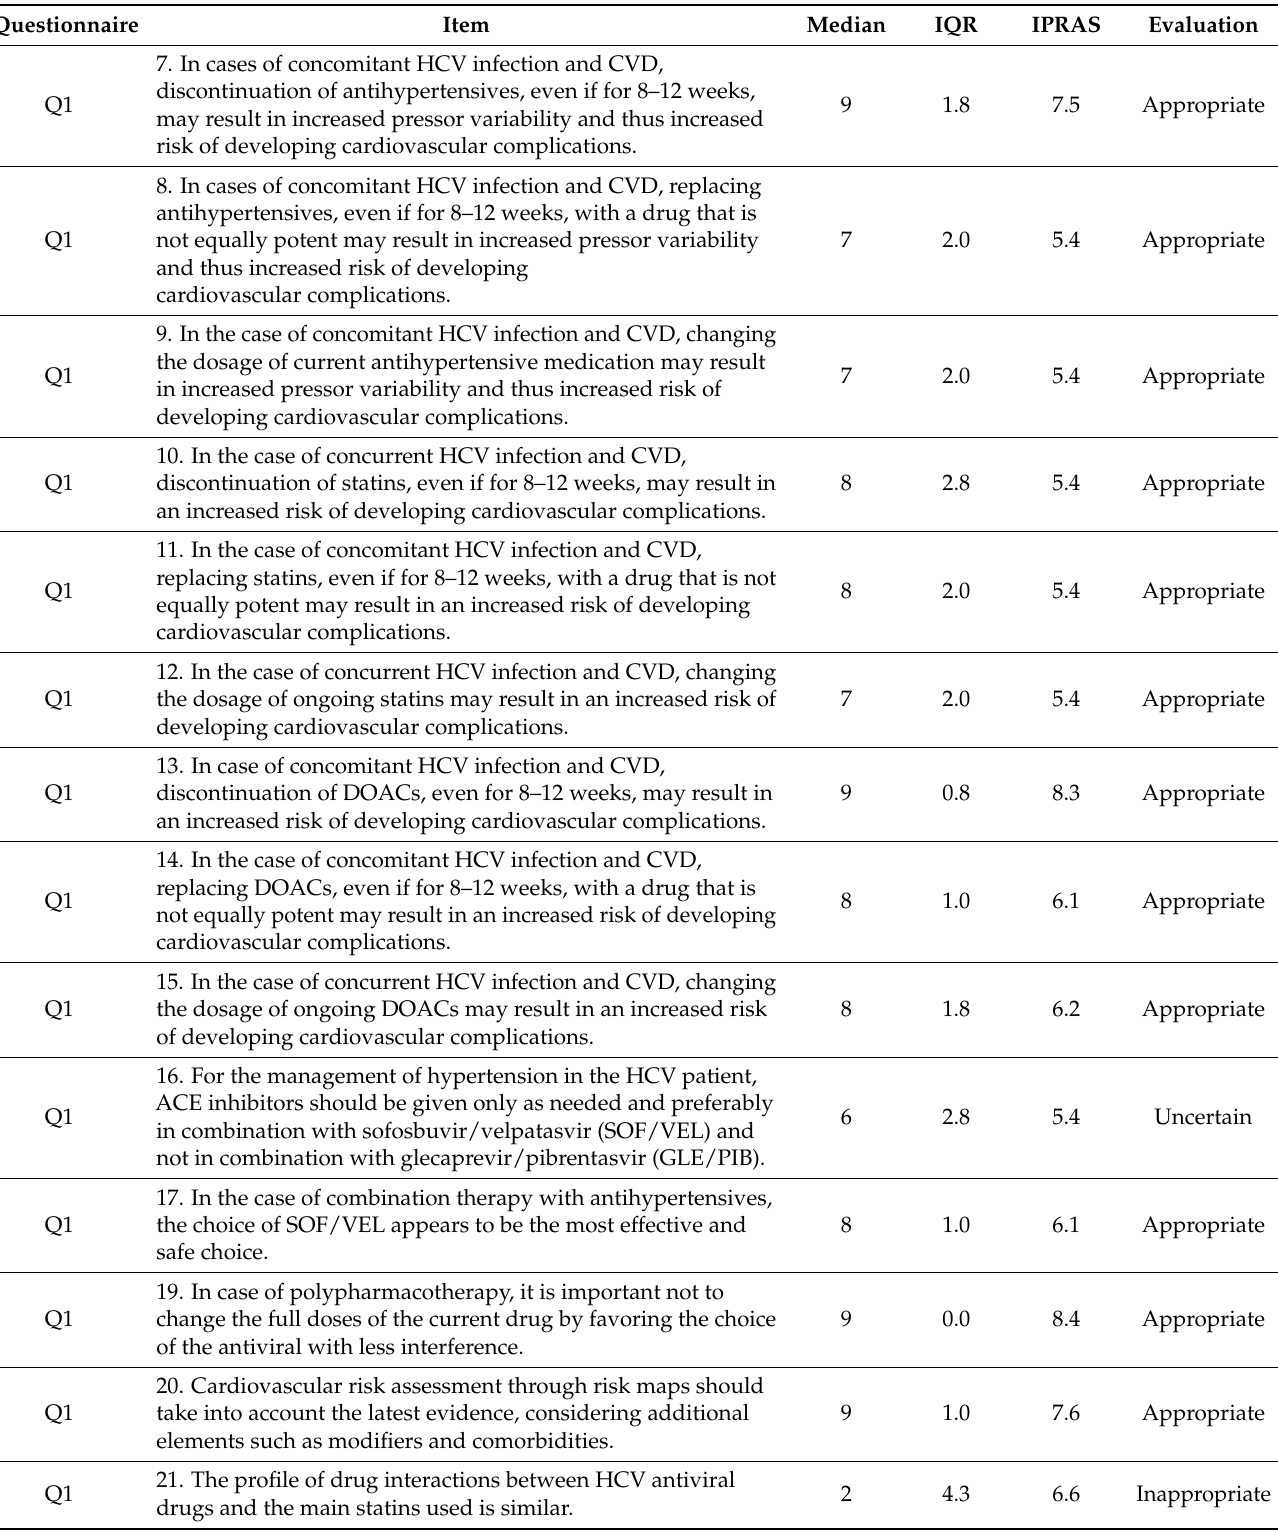
Table 2. Appropriateness Indexes evaluated according to the RAND/UCLA